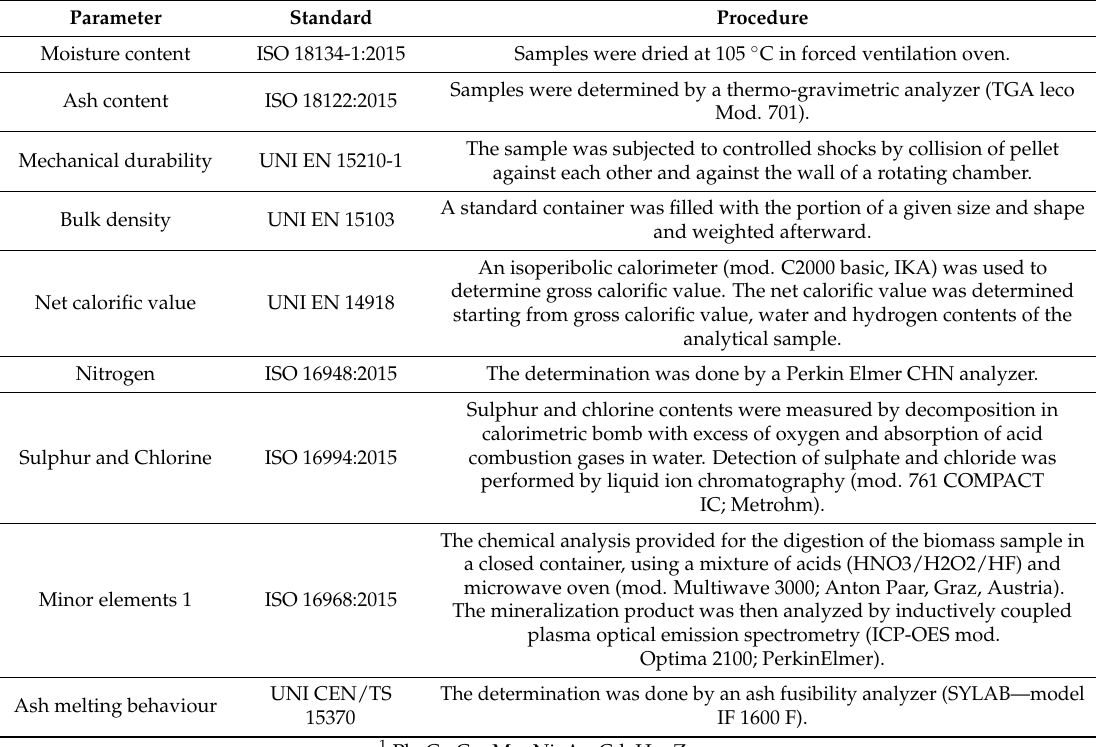
Table 1. Parameters analyzed on biomass according to the reference standards and technical procedures. Parameter Standard Procedure Moisture